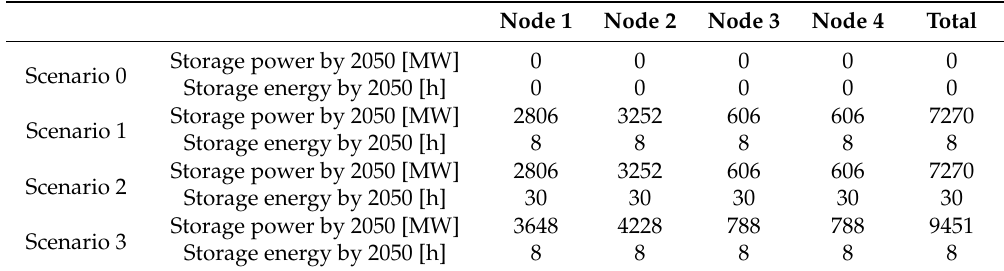
Table 5. Installed capacity of storage for Scenarios 1, 2 and 3 in year 2050.